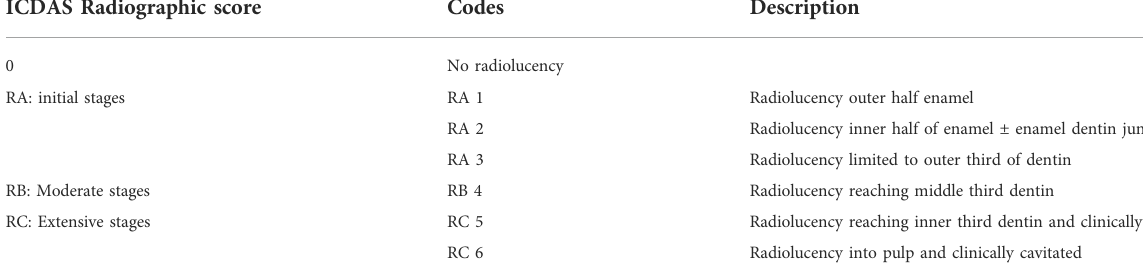
TABLE 3 ICDAS Radiographic Scores adapted from Pitts et al. (2013).